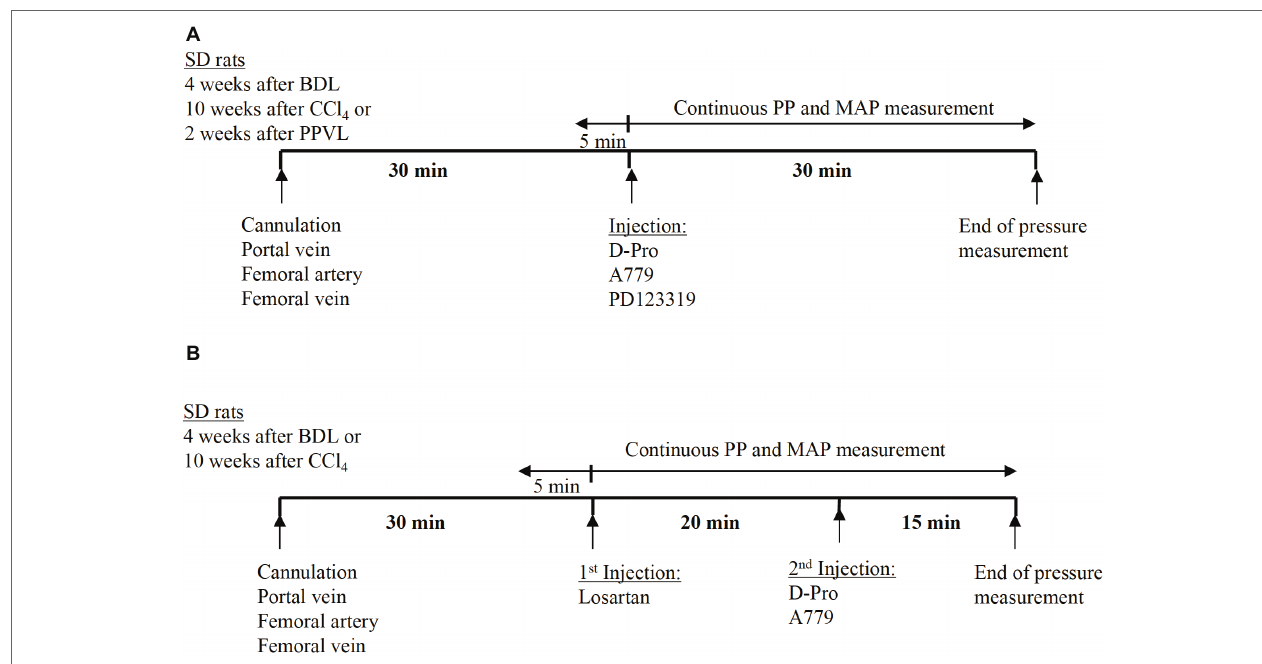
FIGURE 2 | Schematic representation of the experimental plan adopted in the pressure measurement study. Thirty minutes after the cannulation of portal vein and femoral artery, the angiotensin receptor blockers were administered as a bolus injection via the femoral vein catheter. In the experiments using a single receptor blocker injection of either A779, D-Pro, or PD123319, pressure measurement was continued for 30 min after the injection (A) . In the experiments using combined treatment, losartan was injected first, followed by either A779 or D-Pro 20 min later. The pressure measurement was continued for a total of 35 min after losartan injection (B)